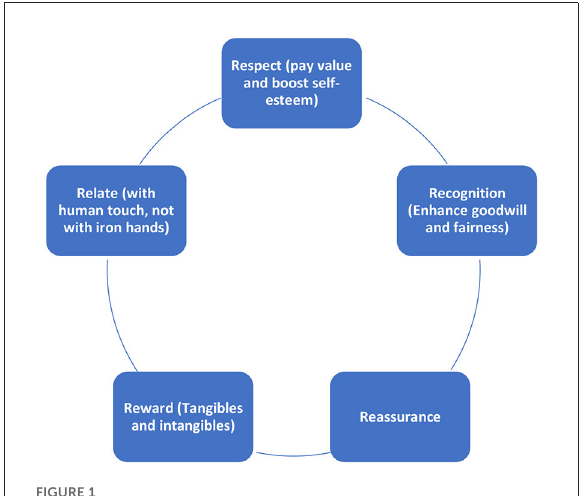
FIGURE1 The 5Rs to influence and motivate students for results. Drawn using source data from Hoban and Nielsen (2010).